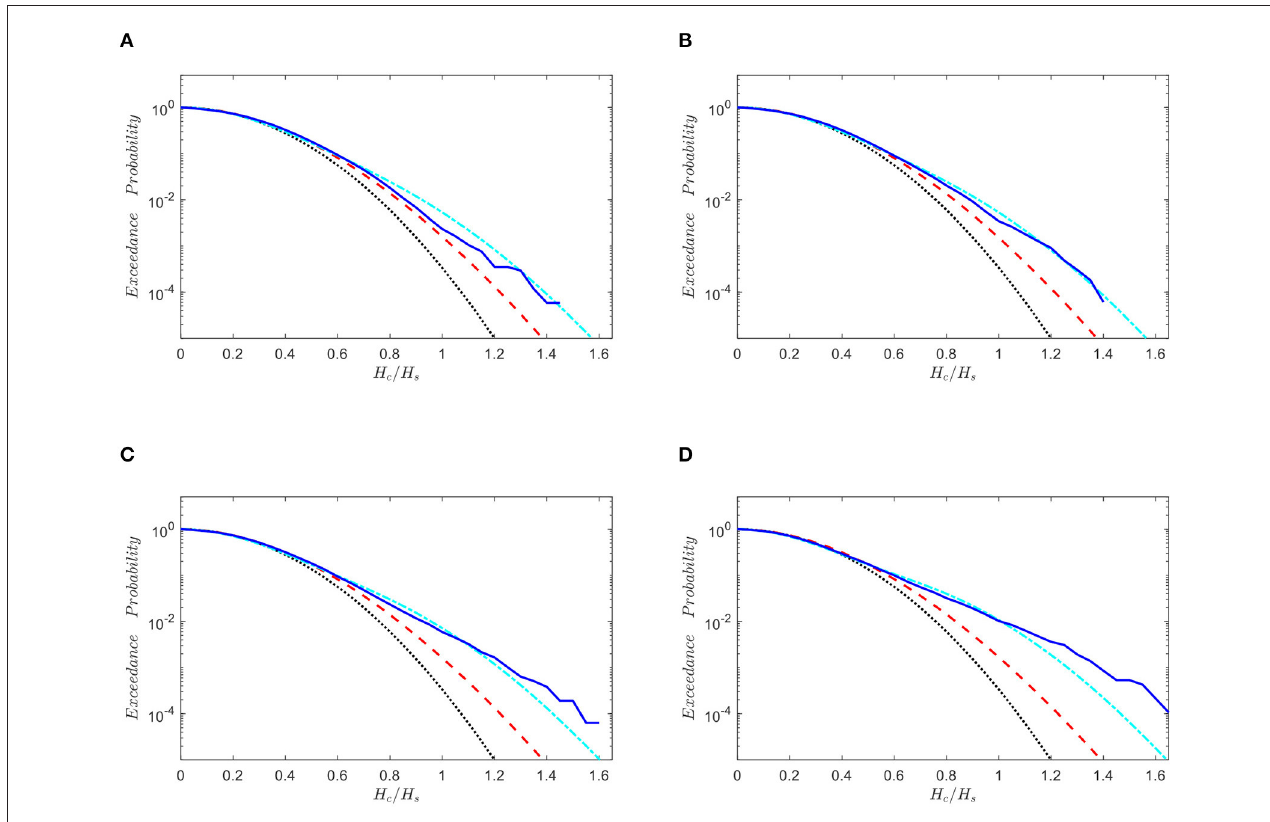
FIGURE 7 | Wave crest exceedance probability. “ distribution; “–”: Numerical results based on ESBI. (A) ν